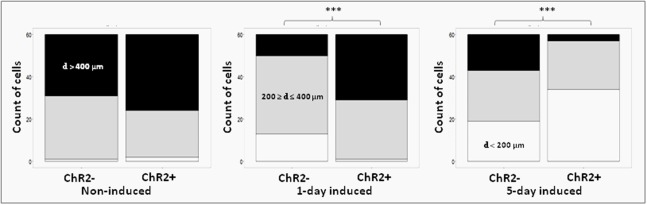
Proportions of cells with different displacement activities. The move of ChR2+ and ChR2- cells was analyzed in non-induced (nChR2+ = 60; nChR2- = 60), 1-day induced (nChR2+ = 60; nChR2- = 60) and 5-day induced (nChR2+ = 60; nChR2- = 60) cultures in three independent experiments. The number of cells which moved to defined distances during the 12-h investigation period (black: d > 400 μm; gray: = 200 μm ≥ d ≤ 400 μm; white: d < 200 μm) was determined. Differences in cell displacements were calculated for ChR2+ and ChR2- cells in each developmental stages. Statistical significances were determined with Pearson’s Chi-squared test and post-hoc Fisher test. The significant (p < 0.001) alterations are indicated by ∗∗∗.